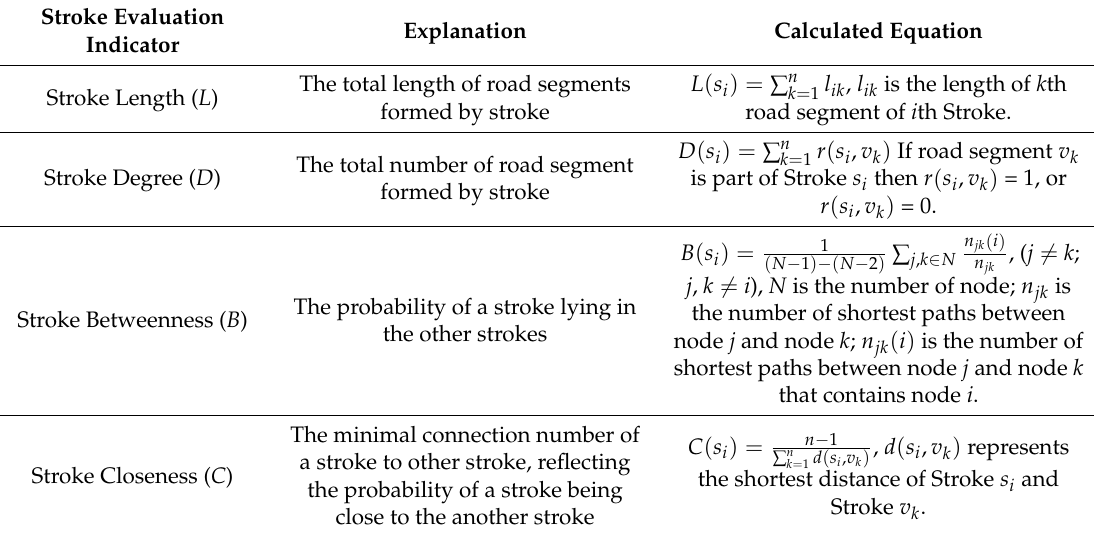
Table 2. Parameter explanation and calculation of stroke